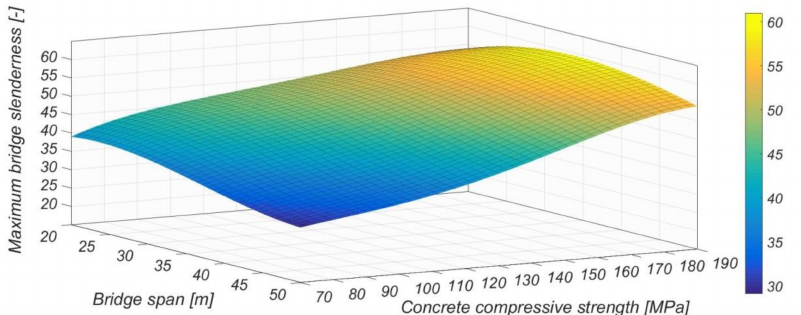
Figure 15. Achievable slenderness calculated with the BoDeTo.